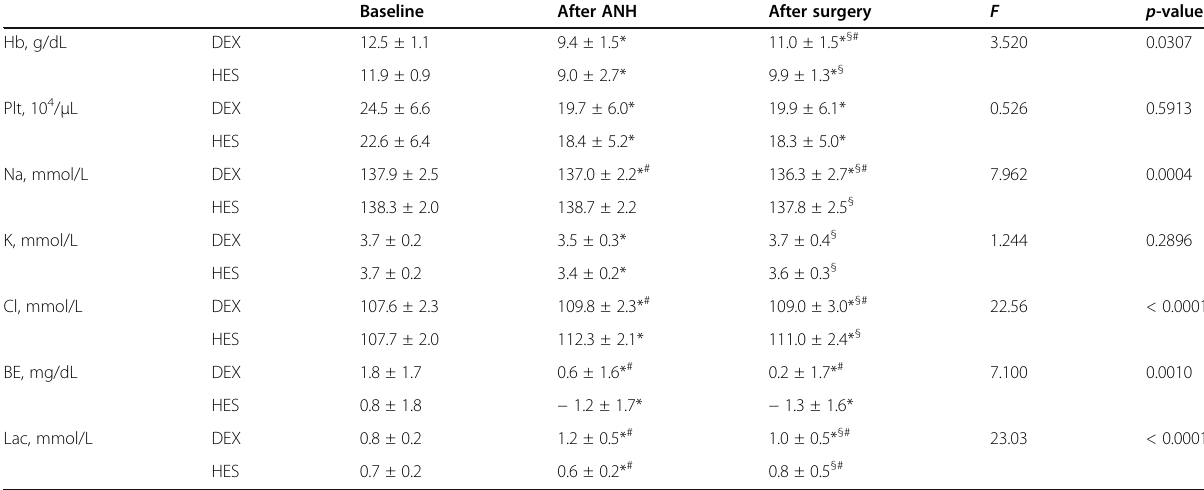
Table 2 Changes in variables during surgery Baseline After ANH After surgery F p -value